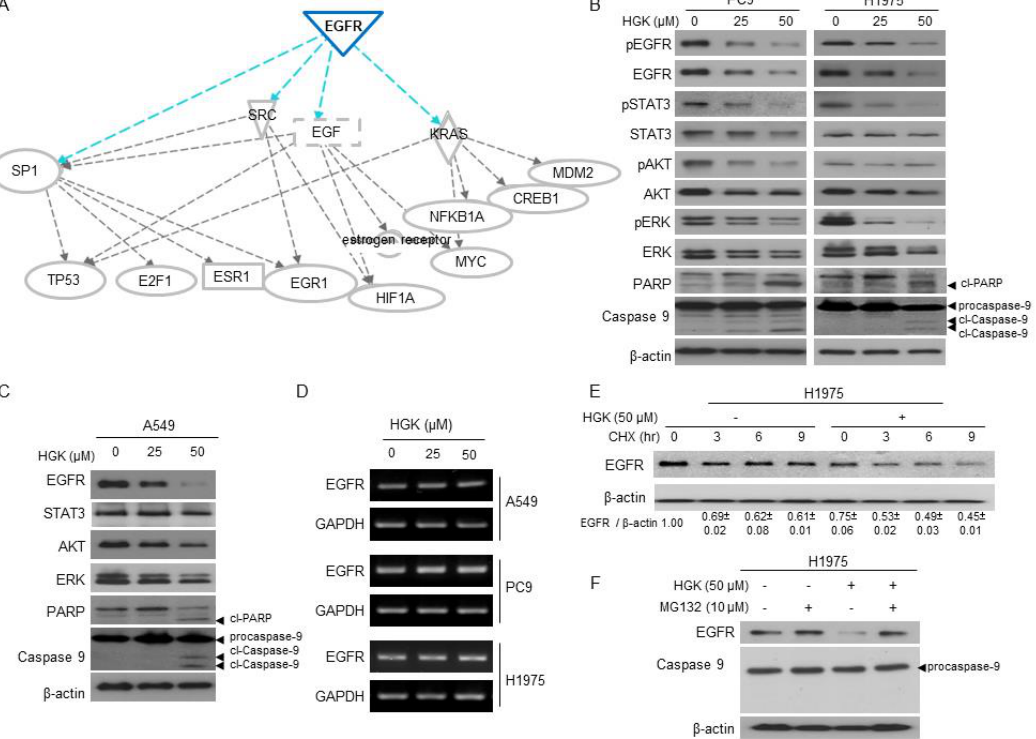
Figure 3. Effects of HGK on epidermal growth factor receptor (EGFR) signaling pathway in NSCLC cells. ( A ) The prediction of EGFR as the upstream transcriptional regulators by using the Ingenuity